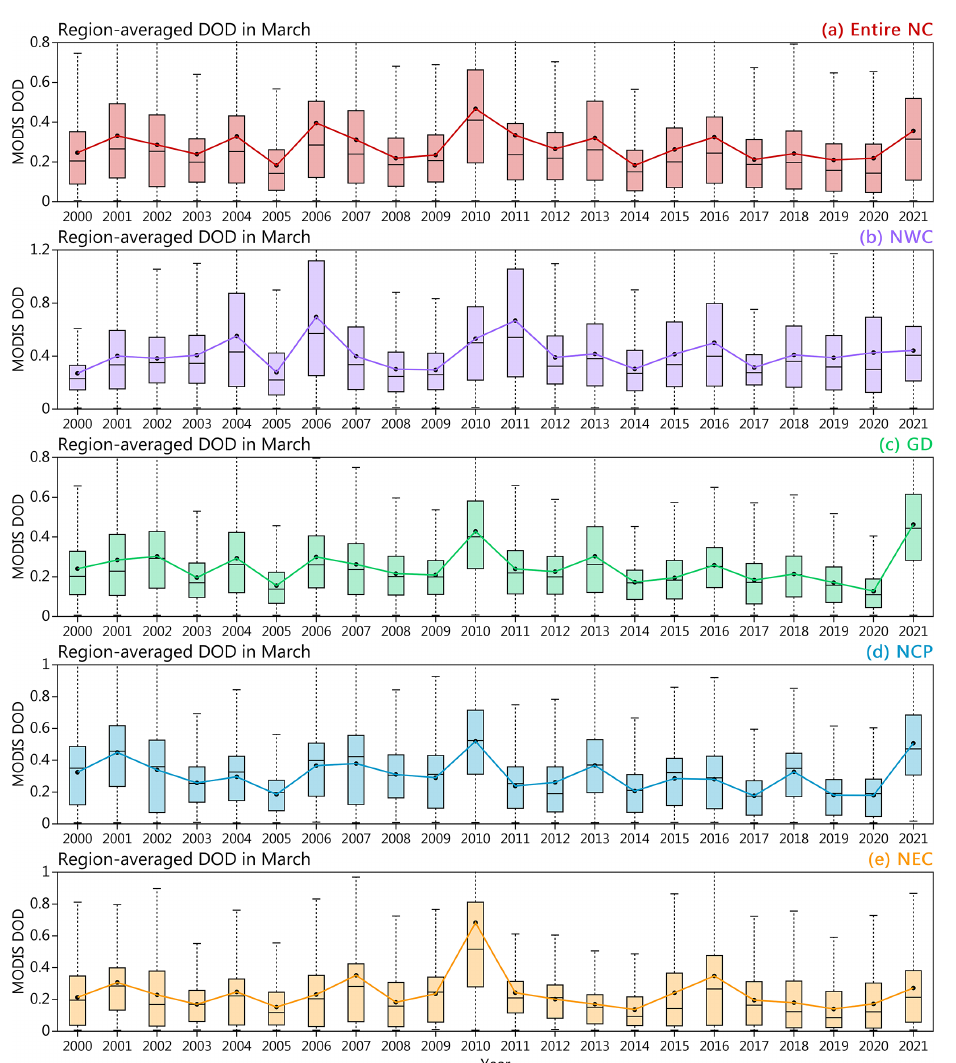
Figure 15. Time-series boxplots of MODIS-retrieved regional-averaged DOD over (a) the entire NC region, (b) NWC, (c) the GD, (d) the NCP, and (e) NEC in March from 2000 to